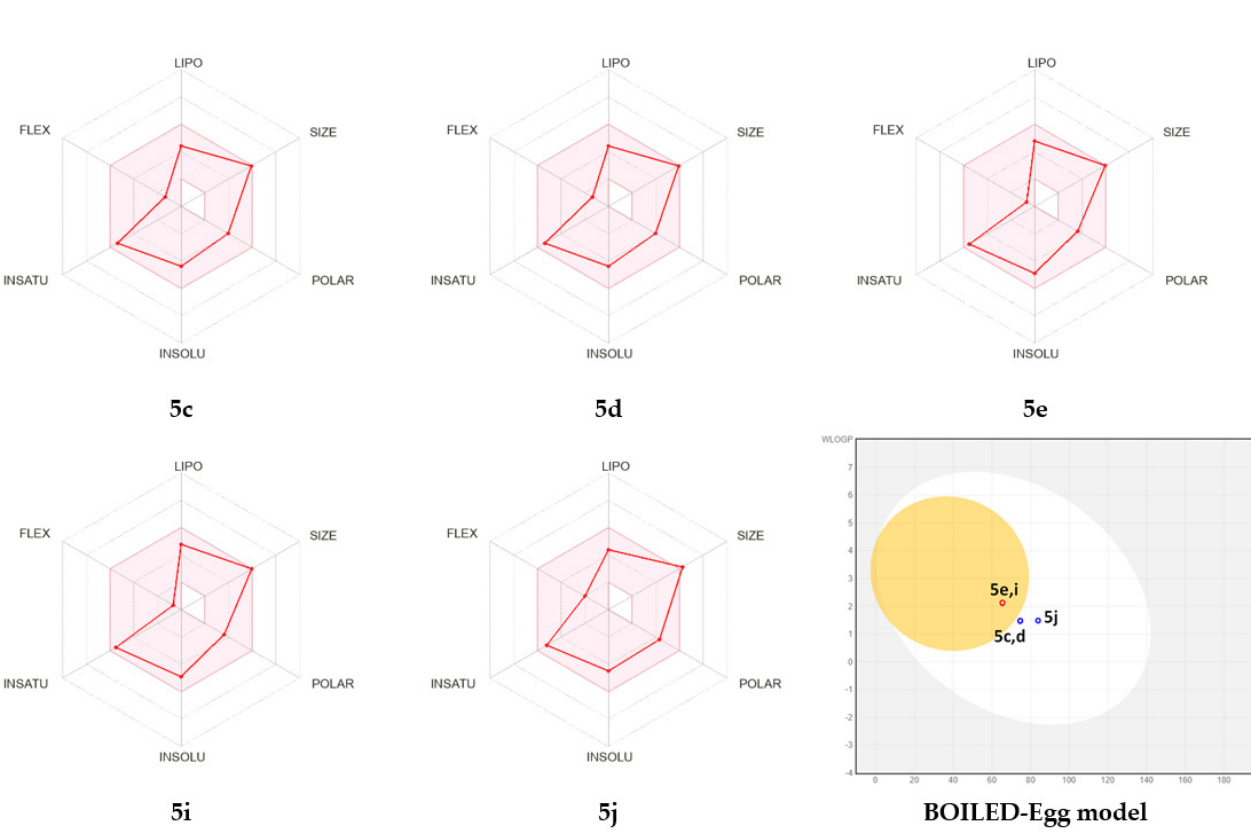
Figure 3. Bioavailability radar and BOILED-Egg model of potent synthesized compounds.